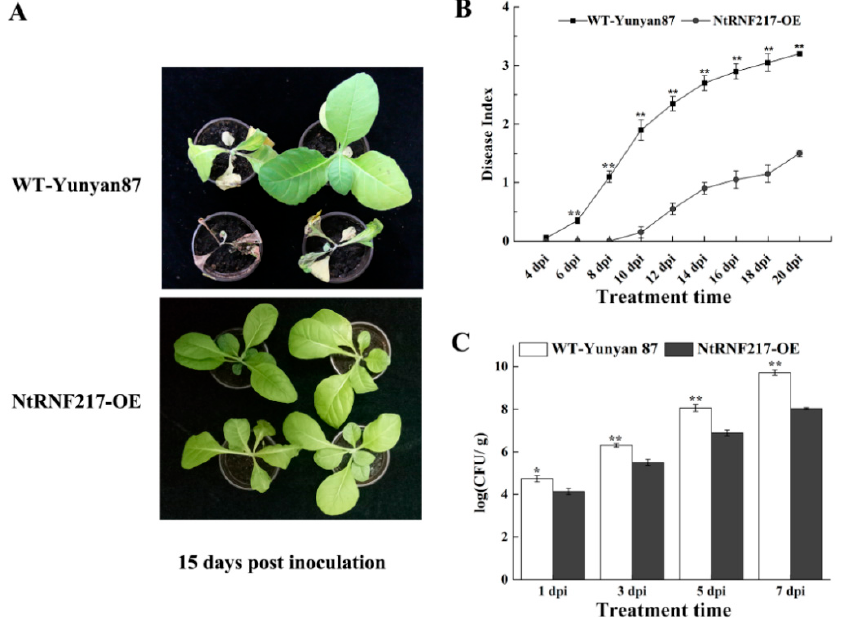
Figure 4. Overexpression of NtRNF217 enhances tobacco resistance to Ralstonia solanacearum . ( A ) The phenotypes of representative NtRNF217 -OE and wild-type (WT-Yunyan87) plants 15 days post inoculation with R. solanacearum . ( B , C ) Disease index of WT-Yunyan87 and NtRNF217 -OE plants inoculated by R. solanacearum and the growth of R. solanacearum in roots. Plants were irrigated with a 10 mL suspension of the highly virulent R. solanacearum strain CQPS-1 (approximate 10 8 CFU mL − 1 ). ‘dpi’ means day post inoculation. Error bars indicated the standard error of three independent biological replicates, Asterisks indicated a statistically significant ( t -test, * p < 0.05 or ** p < 0.01).